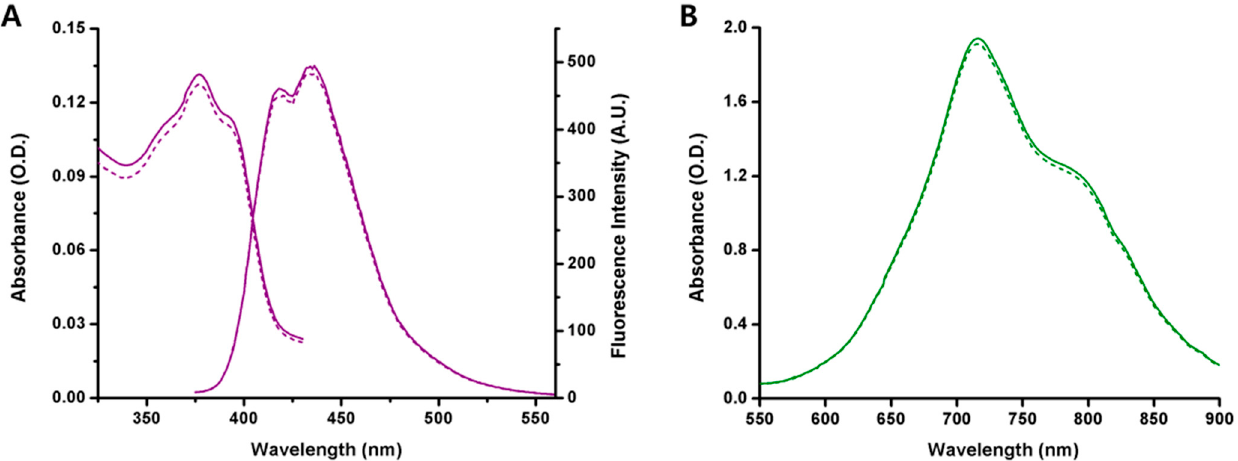
Figure 2. ( A ) Absorption and fluorescence spectra of 0.002% LV-sIPN NPs and ( B ) absorption spectra of 3% IR788-sIPN NPs before and after CMT test.